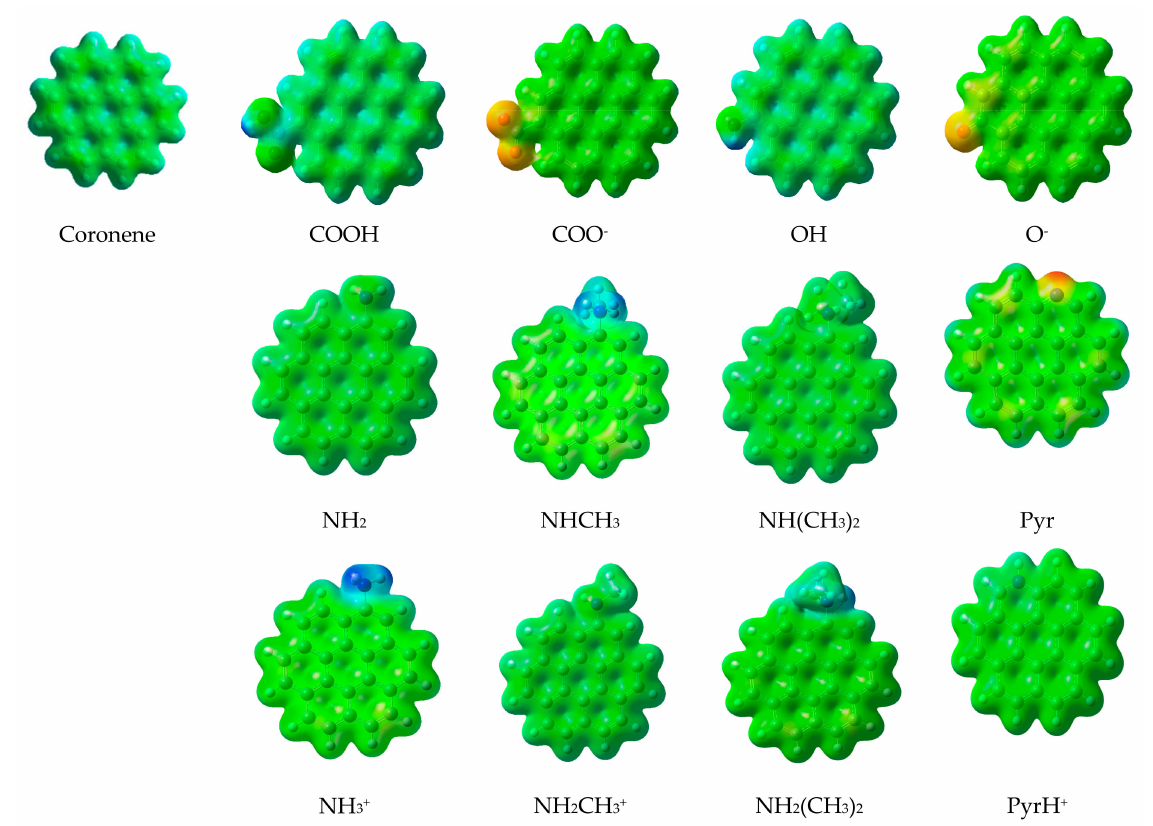
Figure 7. Maps of the total electrostatic potential for coronene, coronene-acidic surface groups (COOH and OH), and their deprotonated forms (COO- and O-); and for coronene-nitrogen-containing basic surface groups (primary, secondary, and tertiary amine and pyridine) and their protonated forms. (Red areas are more negative and blue areas are less